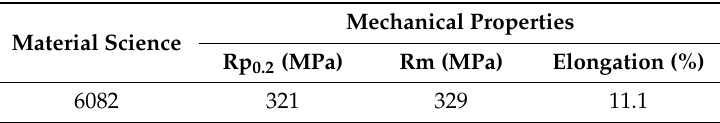
Table 2. Mechanical properties of the 6082 aluminum